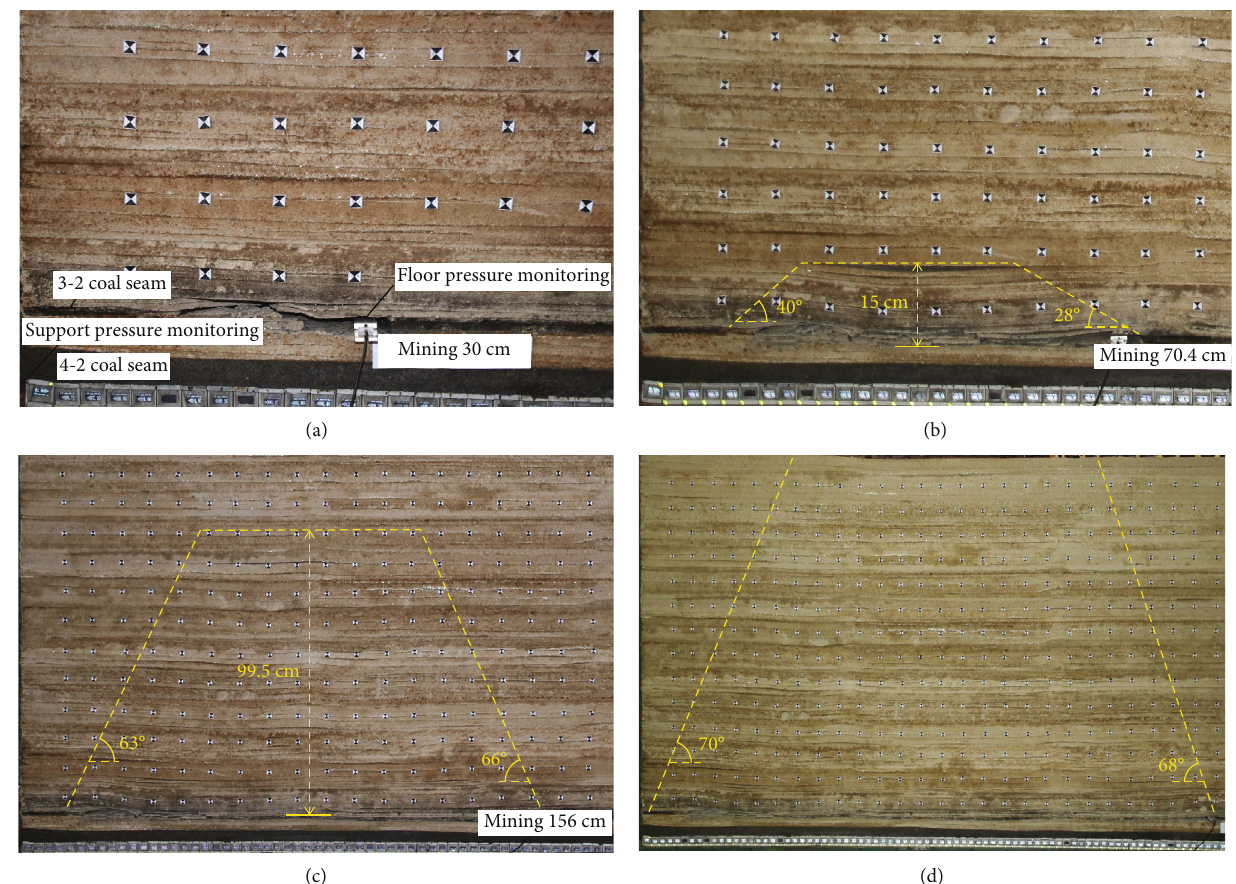
Figure 9: The 2301 working face is opened until the end of mining. (a) The 2301 working face for the fi rst weighting. (b) The 2301 working face for the 7 th weighting. (c) The 2301 working face for the 19 th weighting. (d) End of mining in the 2301 working